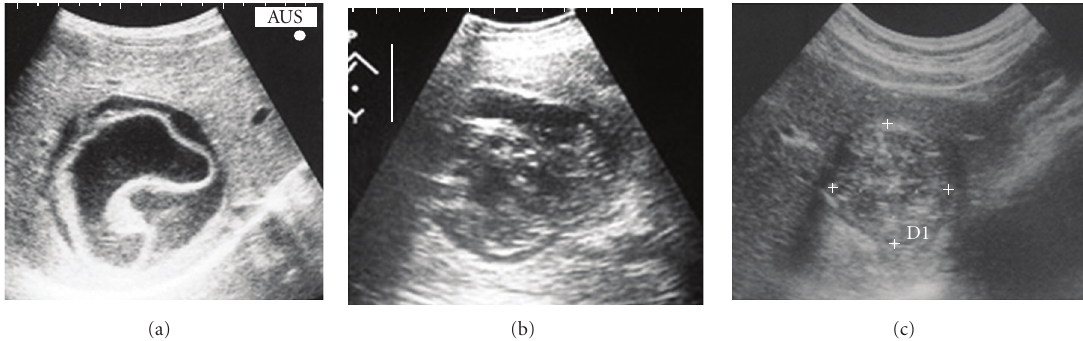
Figure 5: Hydatid cyst of the liver treated with Albendazole: (a) After 1 cycle (3 month); (b) 6 months later; (c) 18 months